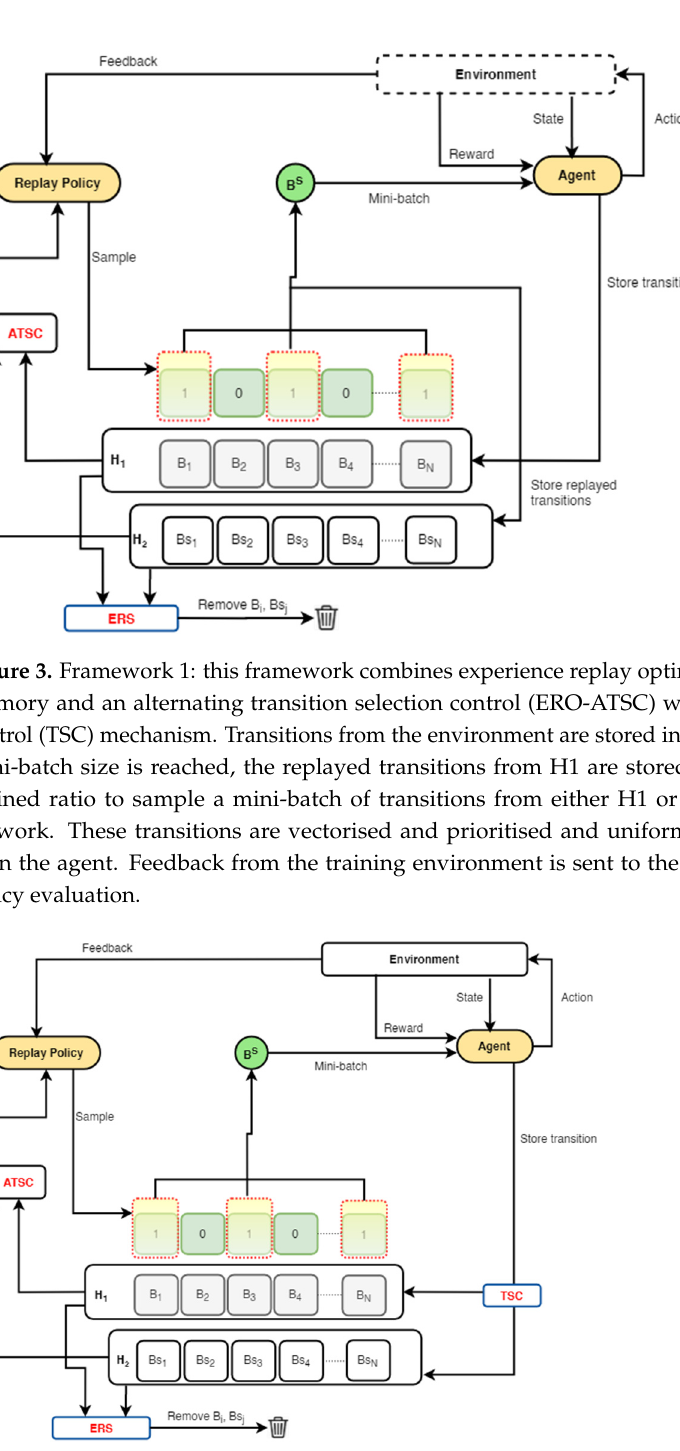
Figure 4. Framework 2: this framework combines experience replay optimisation (ERO) with a dual memory and an alternating transition selection control (ERO-ATSC) with a transition storage control (TSC) mechanism. Transitions from the environment are stored in only H1. When a specified mini-batch size is reached, the replayed transitions from H1 are stored in H2. The ATSC uses a defined ratio to sample a mini-batch of transitions from either H1 or H2 into the replay policy network. These transitions are vectorised and prioritised and uniformly sampled at random to train the agent. Feedback from the training environment is sent to the replay policy network for policy evaluation.